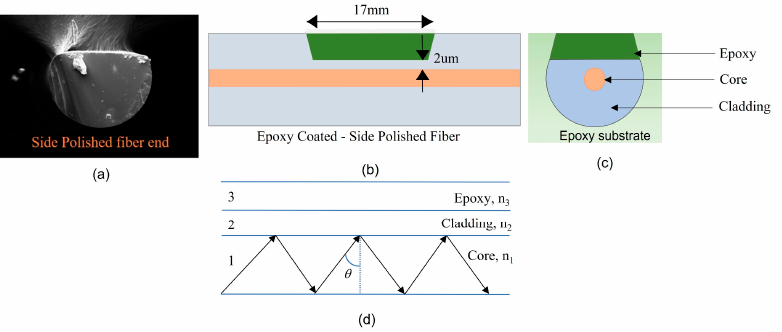
Figure 1. Side-polished optical fiber (SPF) ( a ) SEM cross-section image of SPF, ( b ) schematic diagram of SPF with epoxy coating, ( c ) schematic cross-sectional view of coated SPF, ( d ) refractive index: core, cladding, and epoxy.